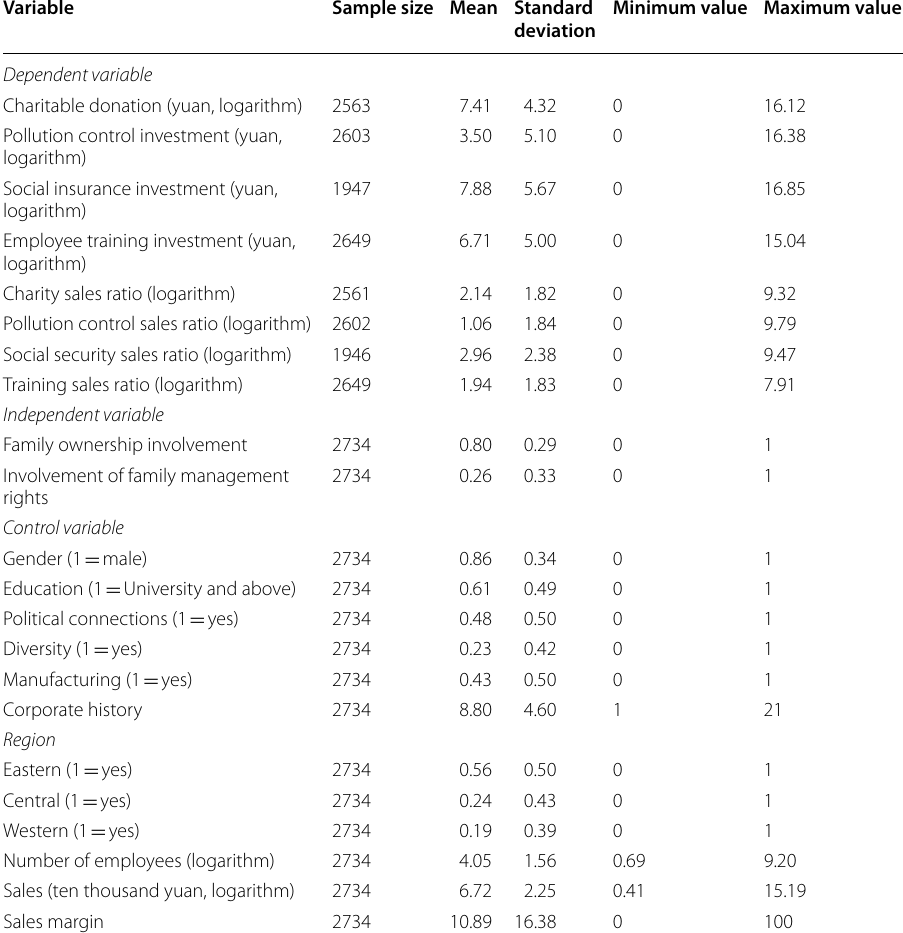
Table 1 Statistical description of main variables